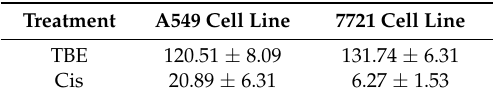
Table 4. IC 50 values ( µ g /mL) of TBE for cytotoxicity